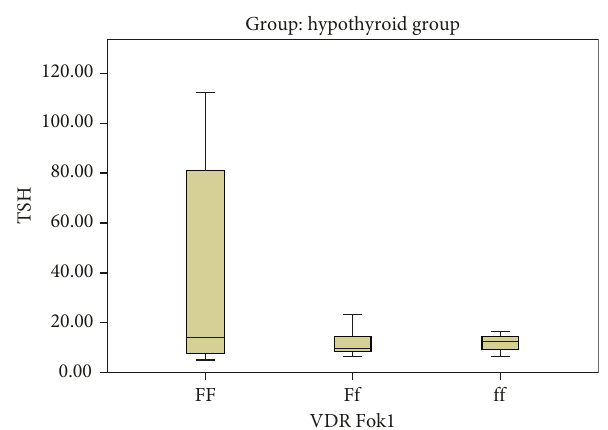
Figure 3: Variation of different Fok1 alleles with TSH level in the hypothyroid group.